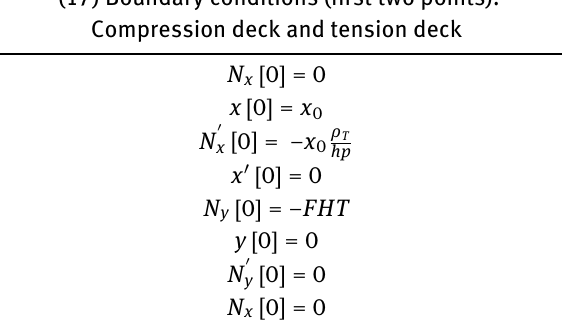
Figure 3: Continuous calculation of the